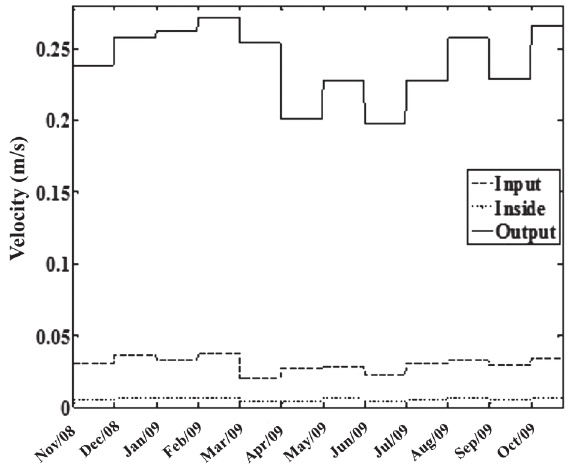
Figure 8 - Velocity module at the three sampling